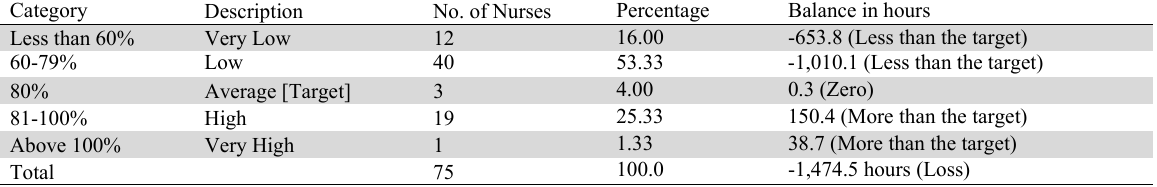
Fig. 1. Actual nurse's outcome in comparison to the target outcome as calculated by TDABC system Analysis of individual nurses outcome as calculated by TDABC